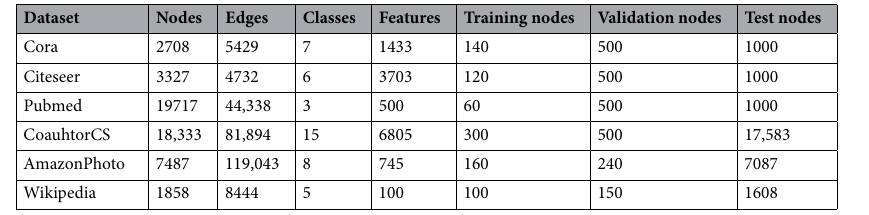
Table 2. Statistics of dataset.